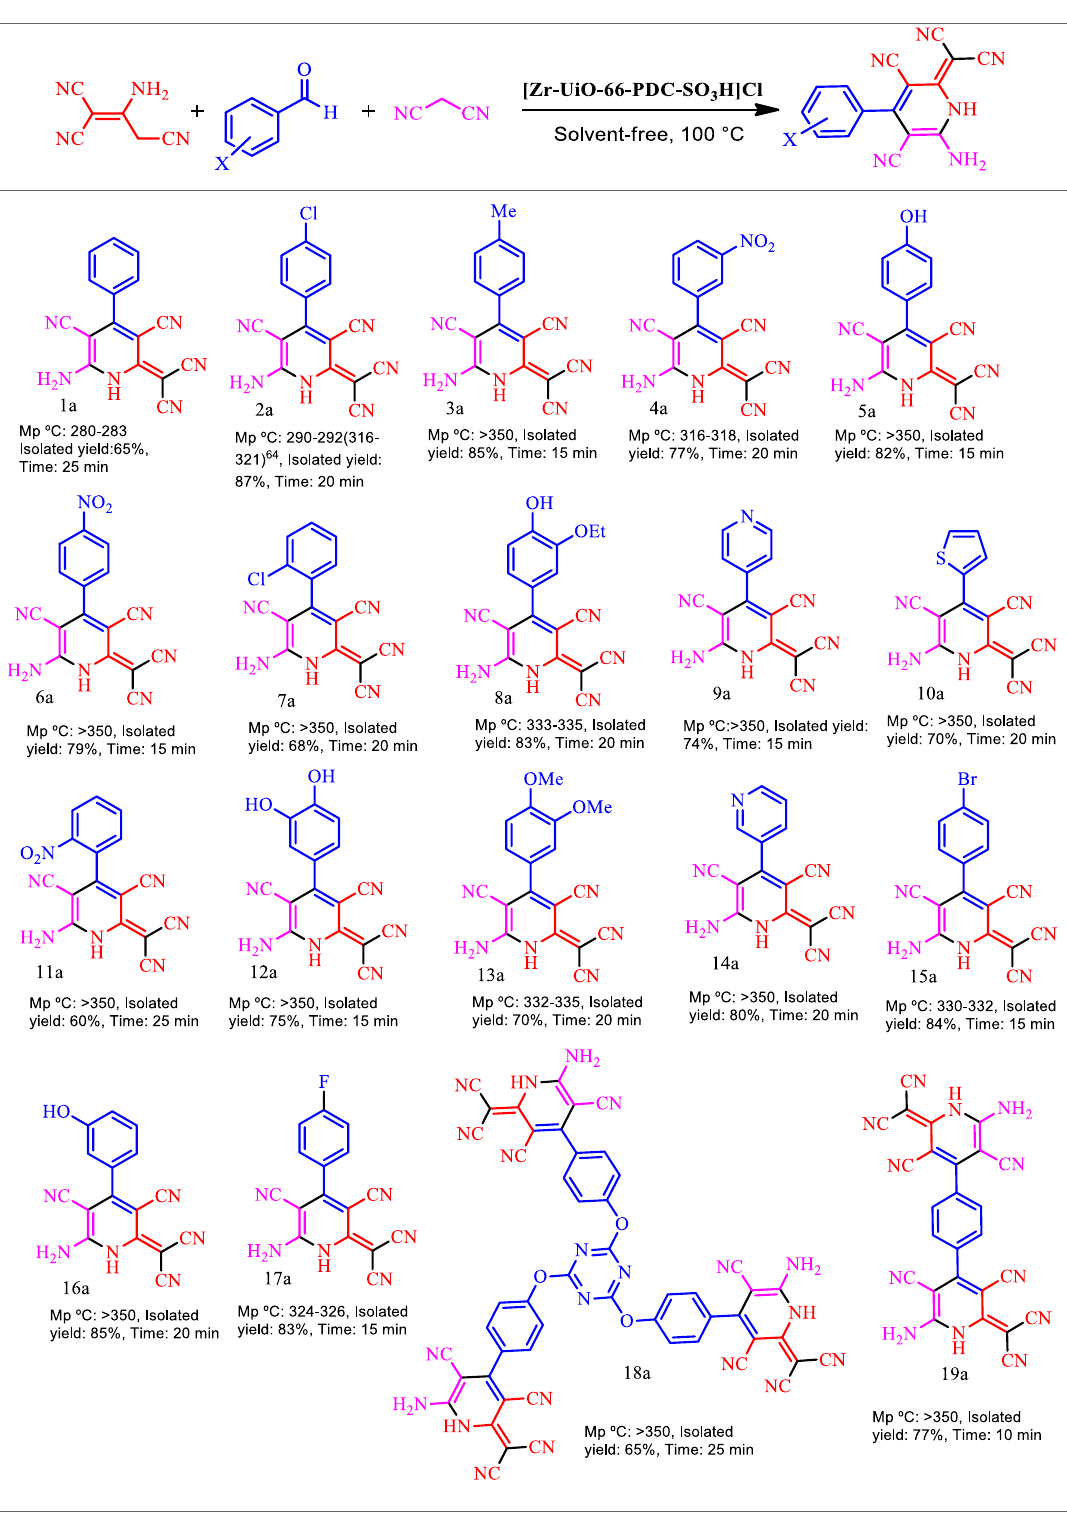
Table 2. Effect of different amounts of catalyst, temperature and solvent (5.0 mL) in the synthesis dicyanomethylene